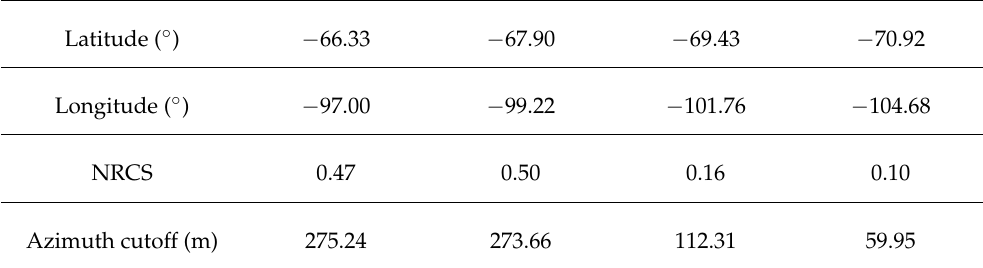
Figure 7. ( a ) Geographical distribution of four consecutive SAR vignettes acquired by S-1A WV1 on 10 June 2017 at 10:46 UTC. The overlapped contour in blue is the daily ice edge derived from the sea ice concentration. Furthermore, the NRCS is given in ( b – e ) for images from the north to the south. Table 1. Image statistics of the four SAR images shown in Figure